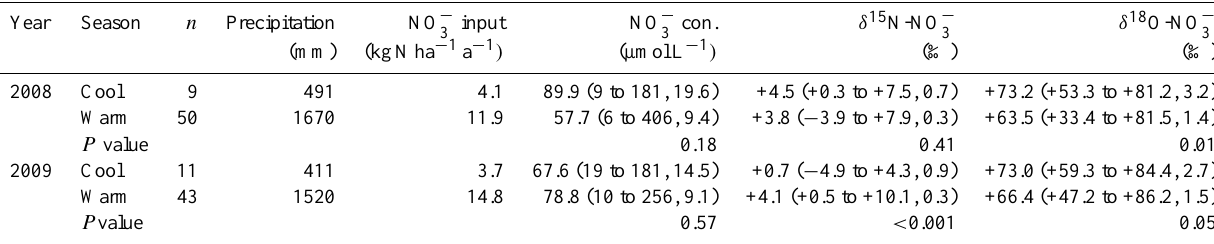
in precipitation. 3